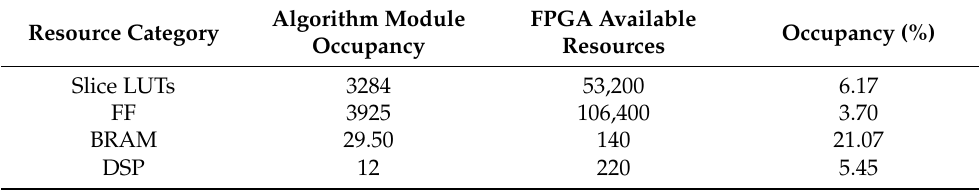
Table 1. Resource occupancy of the line segment detection algorithm.